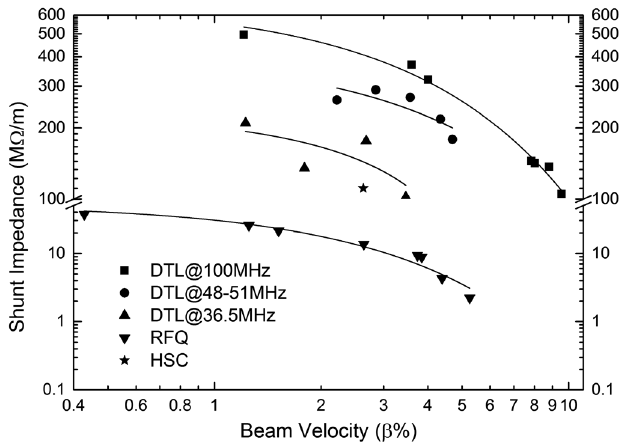
FIG. 8. Comparison of the shunt impedance of the HSC structured linac with that of other linac [16 – 27].